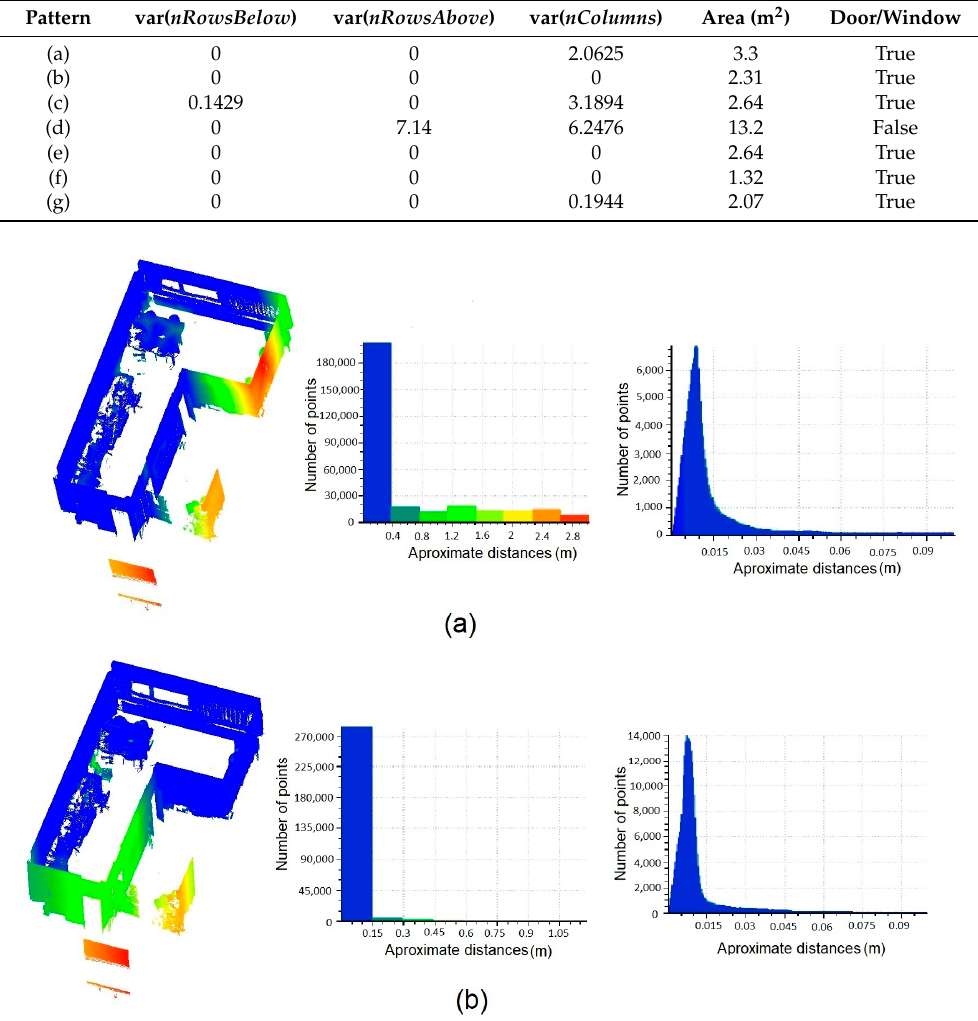
Figure 20. Distance between two consecutive registered point clouds, total distance histogram and partial distance histogram up to 0.1 m. ( a ) Second scan registration; ( b ) third scan registration.